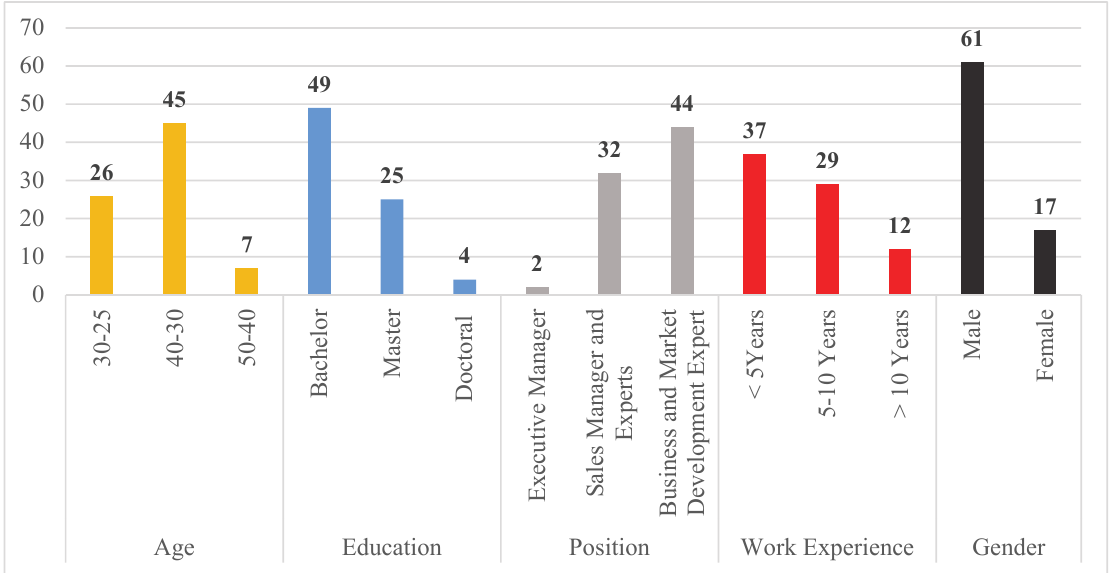
Fig. 1. The demographic features of distribution companies’ participants Trust antecedents and consequences of cosmetics distribution